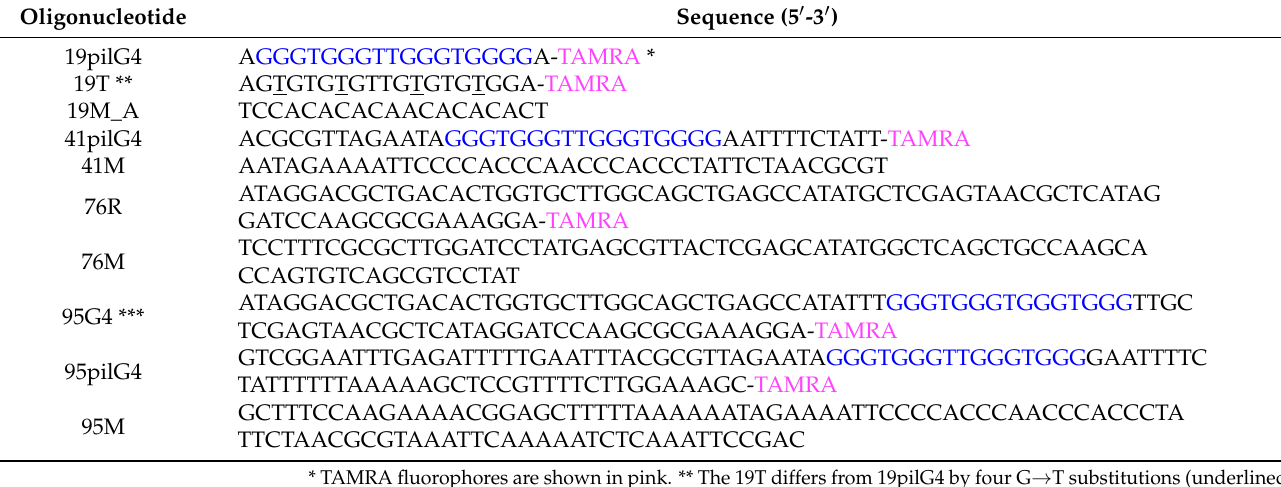
Table 1. Abbreviation and sequence of the synthetic DNA oligonucleotides used in this study (G4 motifs highlighted in blue).